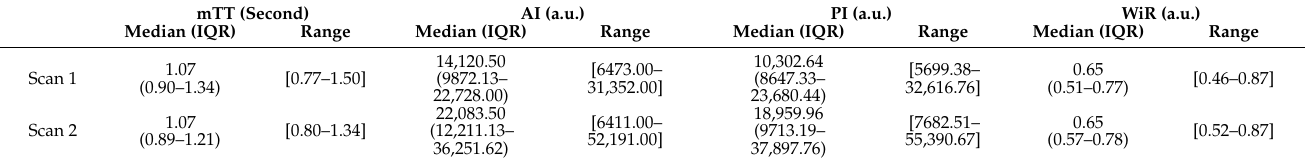
Table 1. CEUS-derived perfusion variables for scan1 and scan2; n = 10.